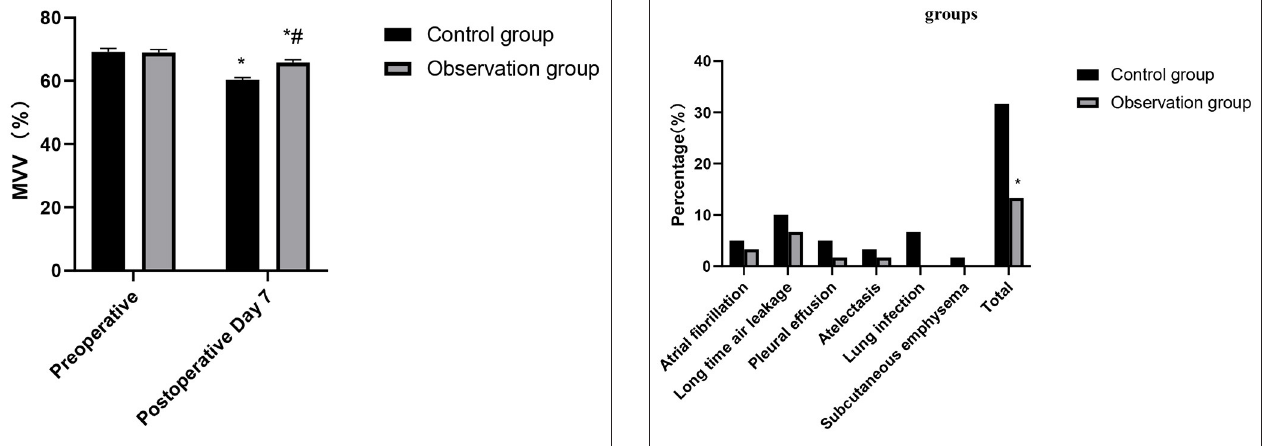
response of the operation to the degree of injury of the